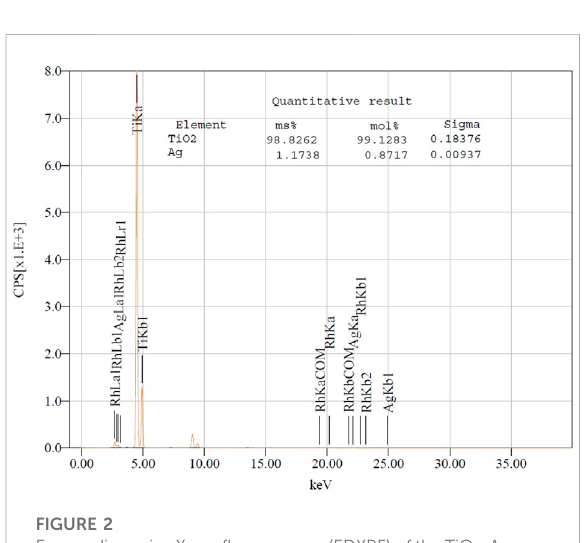
FIGURE 2 Energy dispersive X-ray fl uorescence (EDXRF) of the TiO 2 -Ag catalyst synthesized by the sol gel